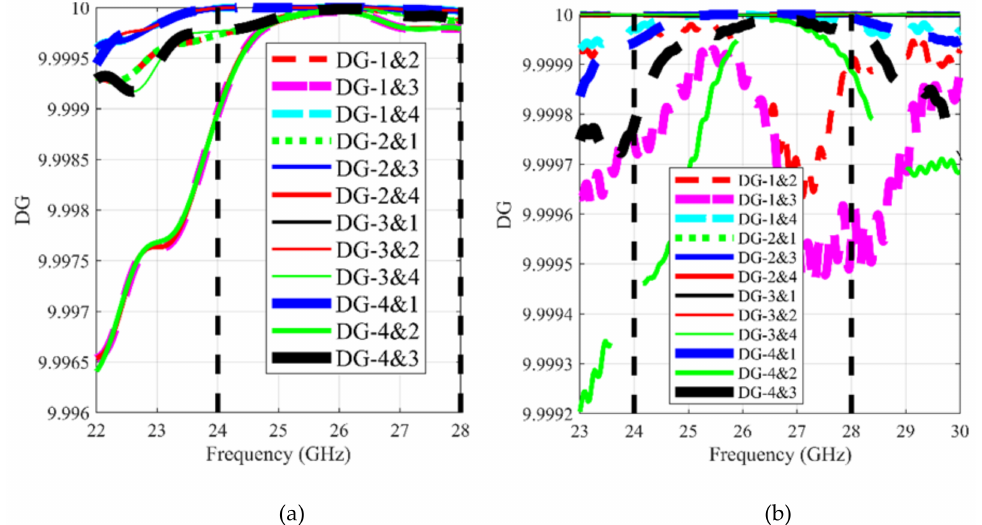
Figure 19. The measured and simulated DG for mmWave MIMO configuration: ( a ) simulated DG; ( b ) measured